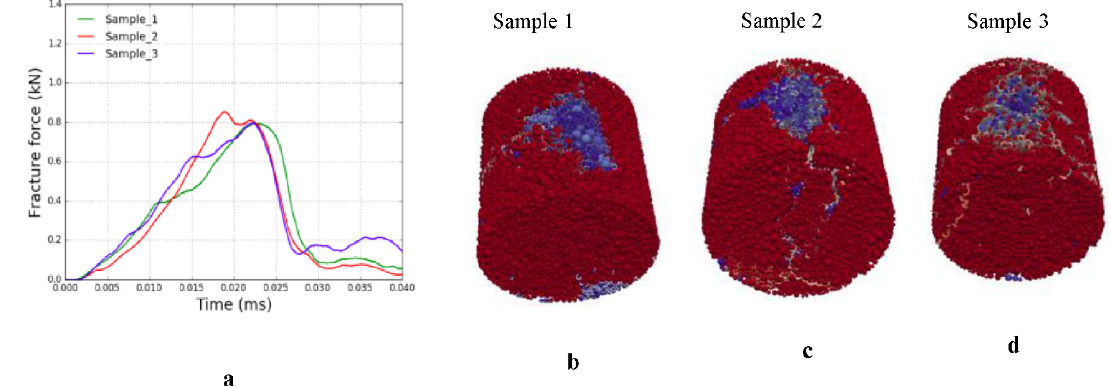
Figure 12. ( a ) Force-time histories of three rock specimens at 180-crack level and ( b – d ) their respective post-process analyses showing the fracture pattern.